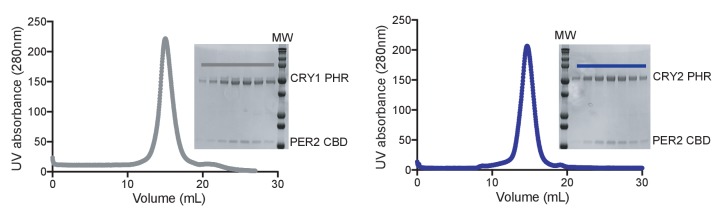
Formation of stable CRY PHR domain:PER2 CBD complexes for binding studies.Gel filtration analysis of CRY1 PHR:PER2 CBD (left, gray) and CRY2 PHR:PER2 CBD (right, blue). Complexes were preassembled on ice and then resolved on a S200 10/300 GL column. Peak fractions were analyzed by SDS-PAGE.